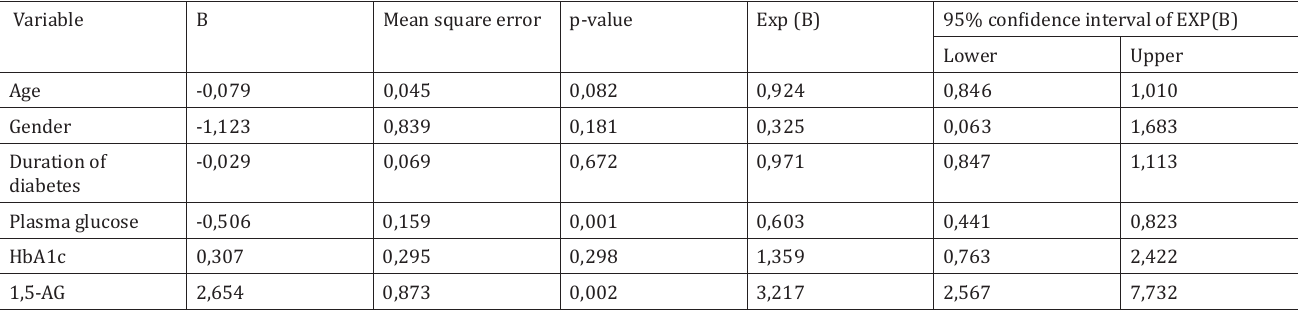
Table 3 The impact of 1,5-AG on the STEMI odds ratio (Binary logistic regression model with covariates